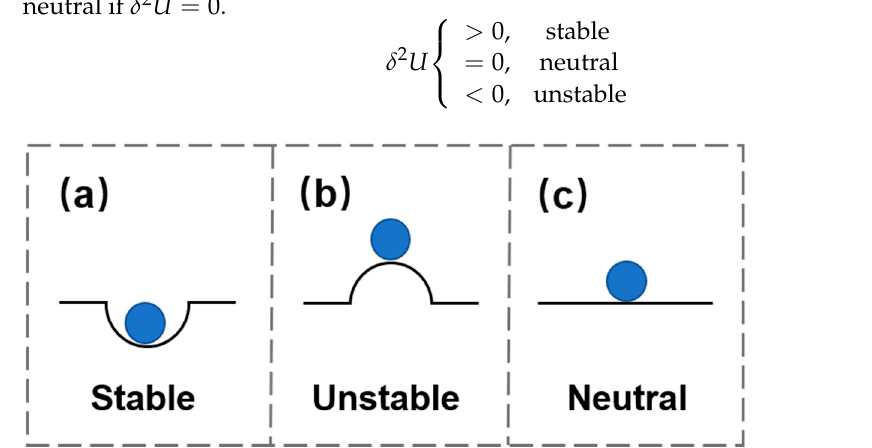
Figure 6. Schematic diagram of structural stability in an energy landscape. ( a ) stable; ( b ) unstable; ( c ) neutral. ( c )